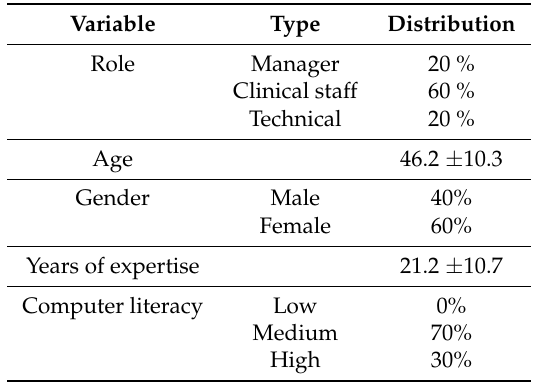
Table 5. Profiles of the participants in the analytic hierarchy process (AHP)